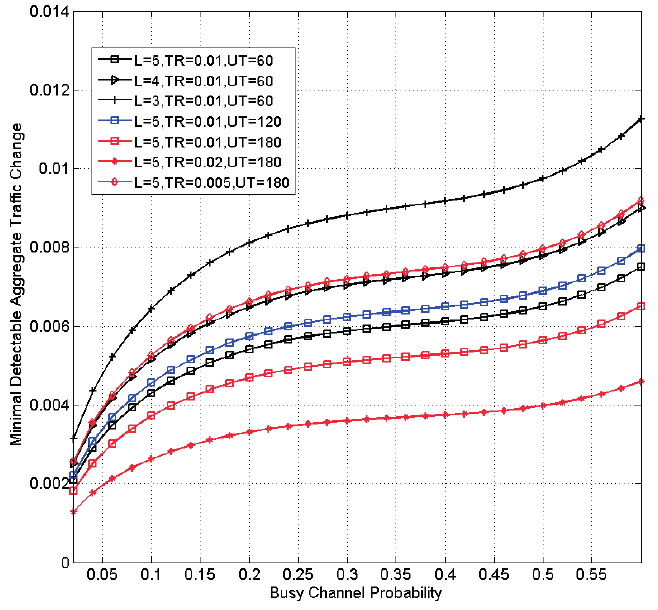
Figure 3. Minimal detectable aggregate traffic change versus busy channel probability (TR: Transmission rate; UT: Update interval